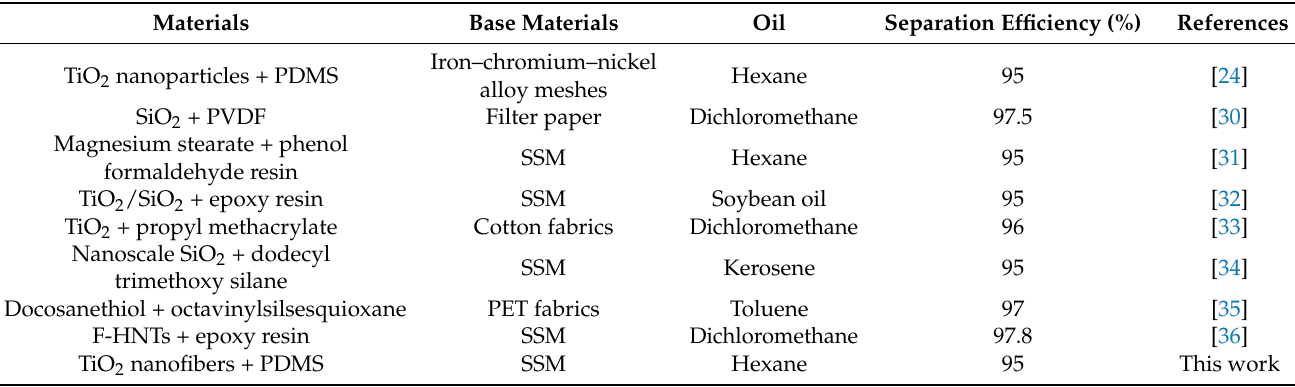
Table 1. Comparison of the SSM and some reported separation